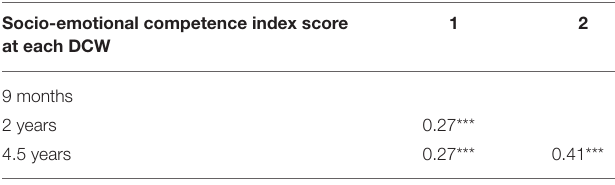
TABLE 7 | Showing pearson correlations between socio-emotional competence dimensions (Easy-going, regulation and exuberance) at Each DCW ( N = 4839). Child